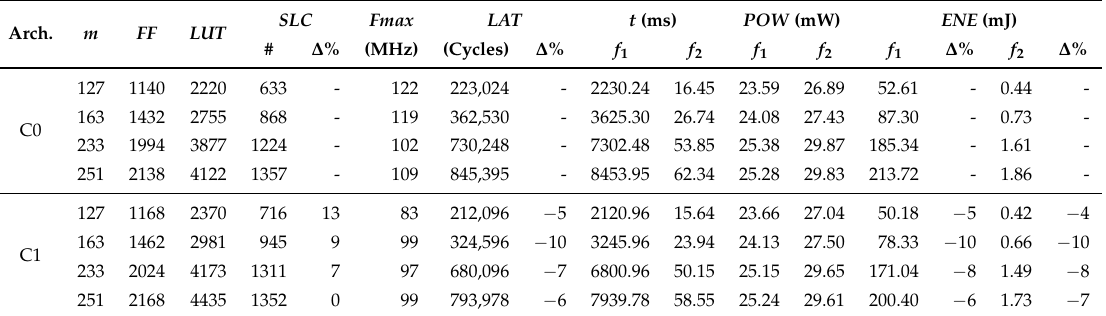
Table 3. Implementation results for C0 and C1 at frequencies of f 1 = 100 KHz and f 2 = 13.56 MHz in the xc6slx16